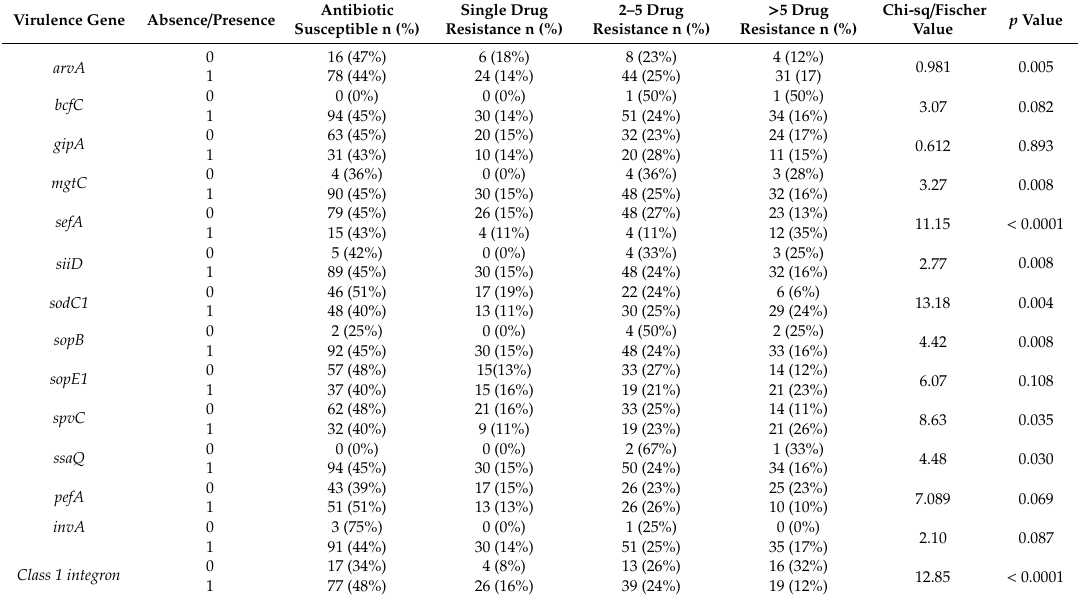
Table 2. Association between multiple antibiotic resistance and virulence genes in Salmonella isolates ( n = 211).